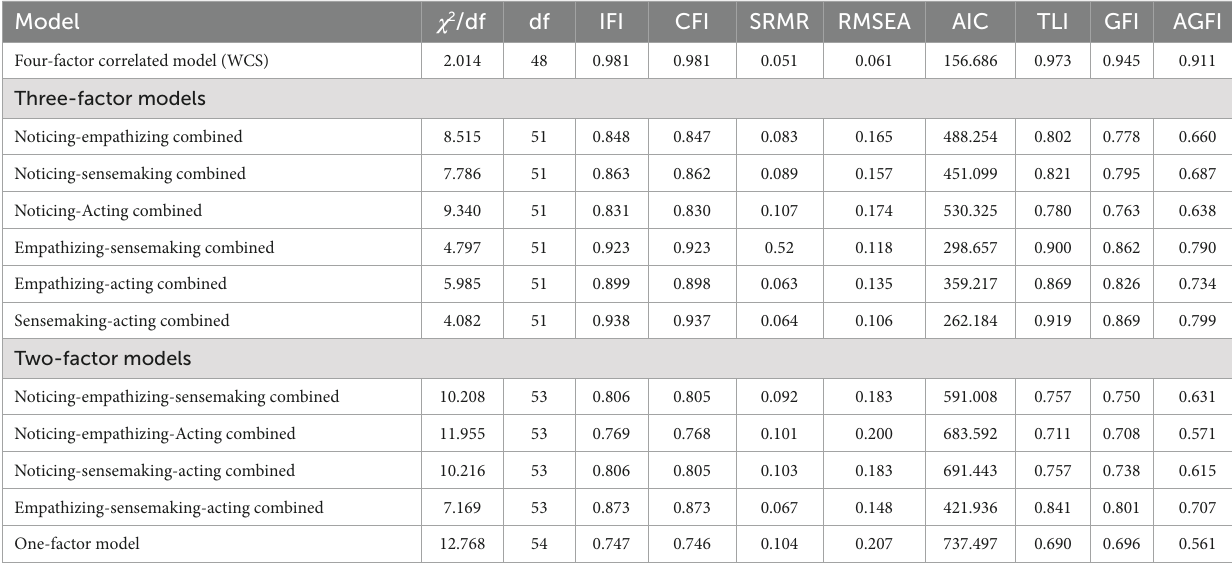
TABLE 5 Model fit measures-confirmatory factor analysis for study 2 ( N = 276).